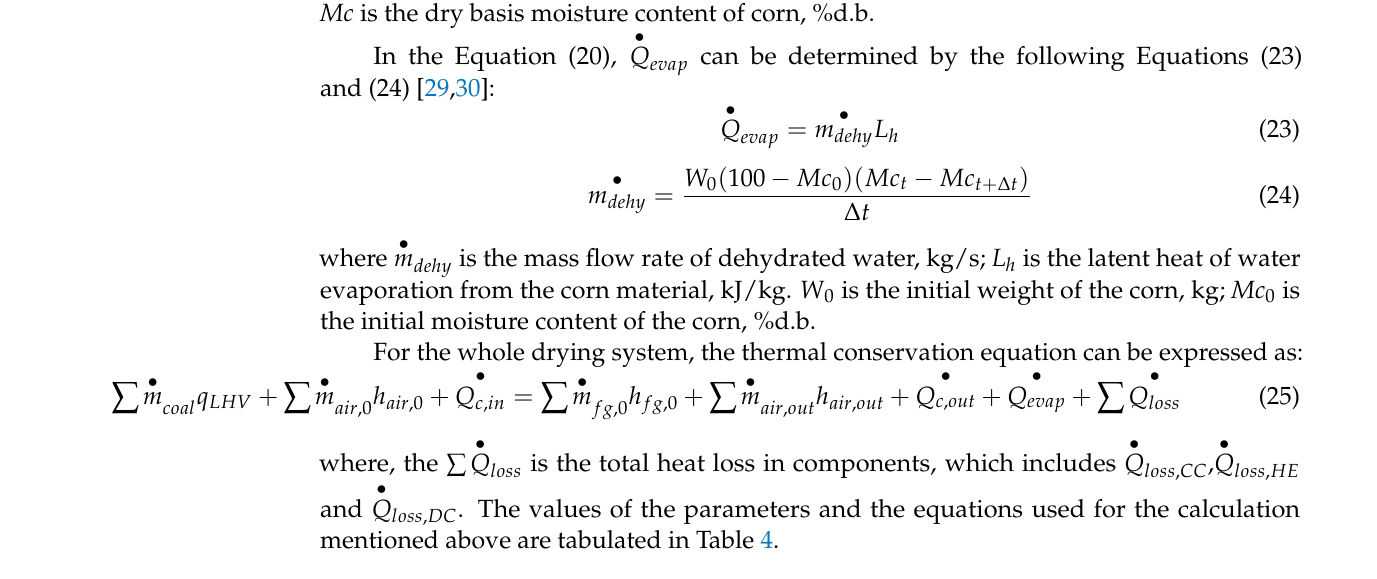
Table 4. The values of the parameters and equations used in the present